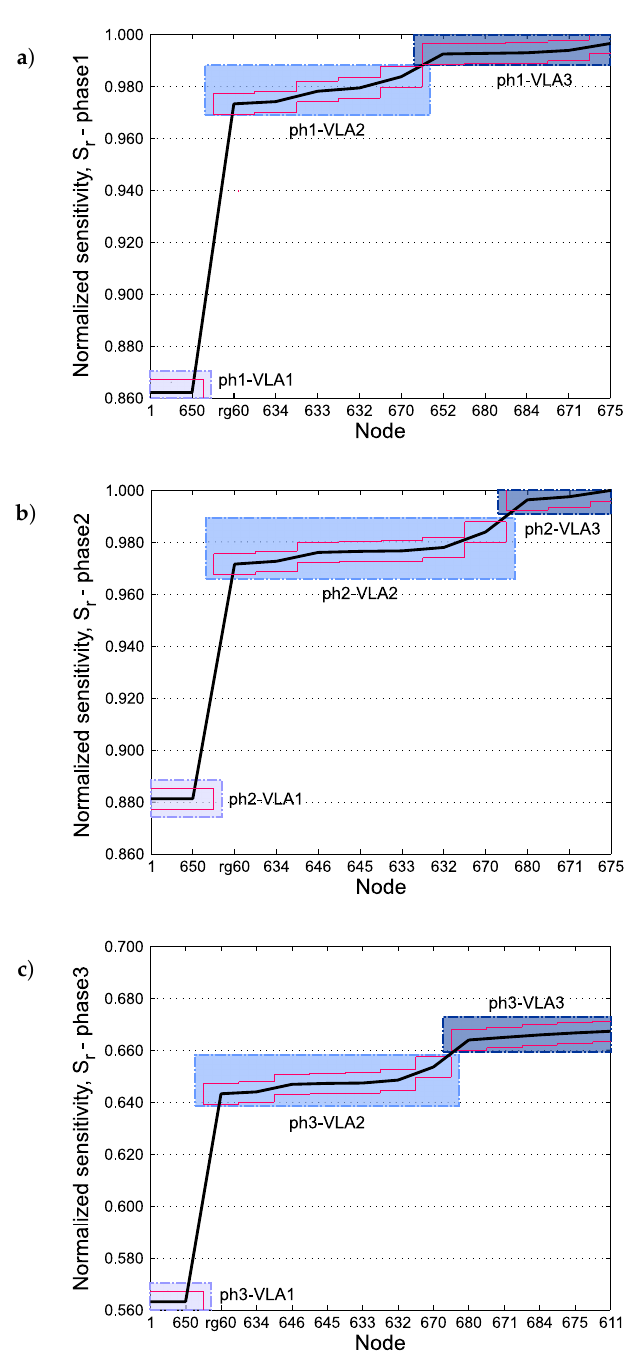
Figure 10. Voltage sensitivity analysis for the small-size grid—( a ) phase 1; ( b ) phase 2; and ( c ) phase